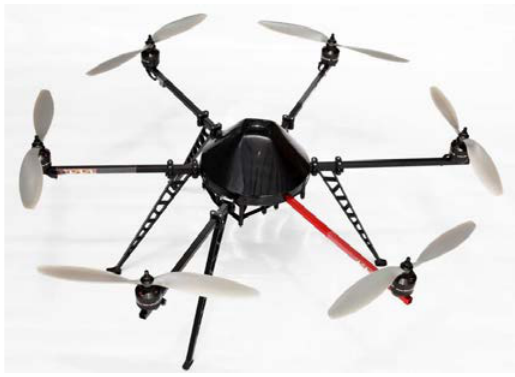
Figure 3. Octocopter [mikrokopter.de]